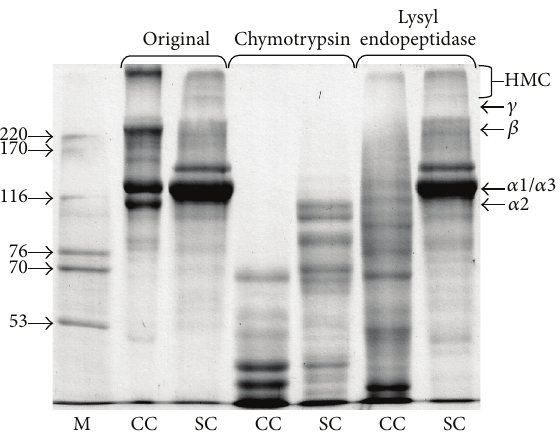
Figure 4: Peptide maps of collagen from the skin of splendid squid (SC) and type I collagen from calf skin (CC) digested by lysyl endopeptidase or chymotrypsin. M and HMC denote high- MW protein markers and high-MW cross-linked components,